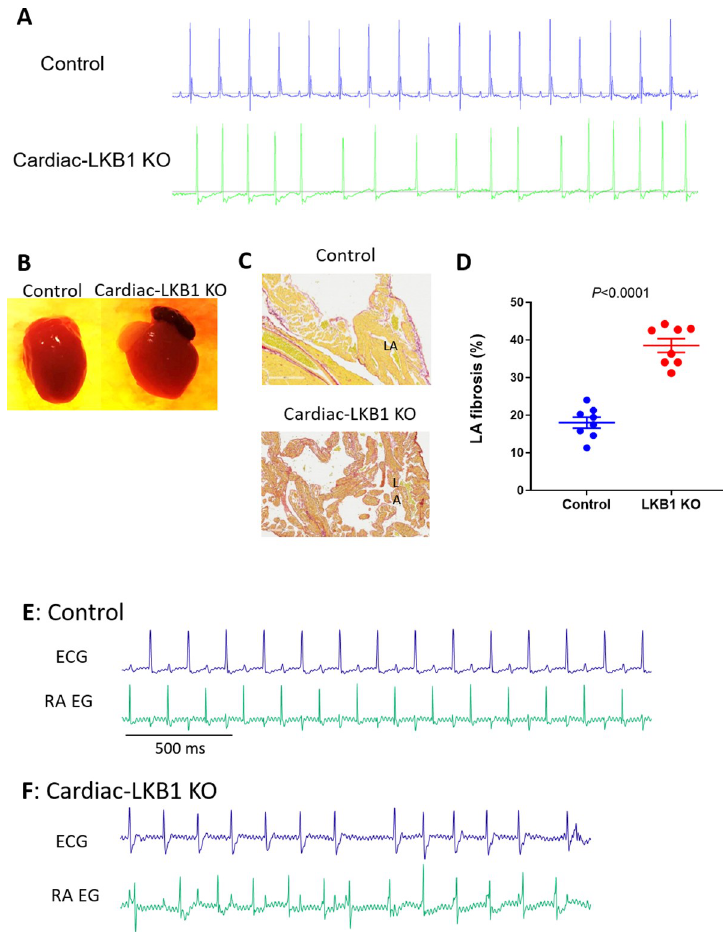
Fig 4. ECG, heart histology and RA electrogram traces in Cardiac-LKB1 KO mice. A: Representative ECG traces from telemetry-implanted control and Cardiac-LKB1 KO mice. B: Representative macro images control and Cardiac- LKB1 KO mouse hearts. Cardiac-LKB1 KO mouse had enlarged atria relative to control atria. C: Representative images of fibrosis staining of the control and Cardiac-LKB1 KO mouse atria. Cardiac-LKB1 KO mouse had increased red staining, indicative of collagen positive areas, in the atria relative to control atria. D: % of positive red stain area over entire LA and RA tissue in control and Cardiac-LKB1 KO mice (n = 8 for each group). Each point indicates individual animal data, and lines represent mean ± SEM. E: Control mice showed sinus rhythm, clear P waves and corresponding RA signal on RA EGs under anesthesia. F: Cardiac-LKB1 KO mice showed irregular RR intervals without P waves on ECG. RA EGs revealed independent and irregular atrial